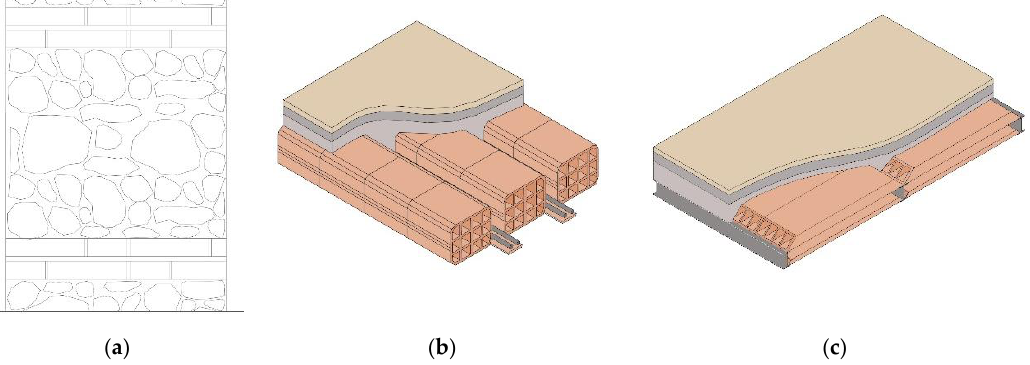
Figure 7. Construction technology: ( a ) stone masonry, ( b ) reinforced concrete slab and hollow block cast in place, ( c ) slab made of double T beams and brick hollow flat blocks.